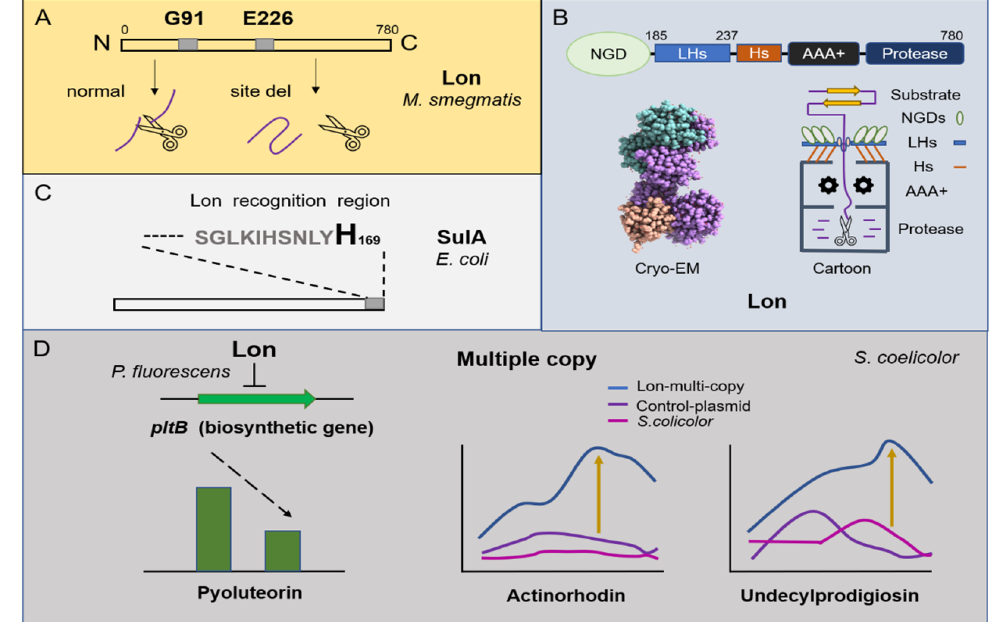
Figure 1. Overview of the degradation mechanism of Lon protease and its regulation on metabolism. ( A ) N-terminal amino acids G91 and E226 of Lon protease from Mycobacterium smegmatis are the most important active sites. ( B ) The cartoon structure of Lon protease and the Cryo–EM structure of the N-terminal domain of Lon E. coli (The Cryo–EM structure was downloaded from the PDB database). The whole length of Lon contains N-terminal globular domains (NGDs), three-helix bundles (3Hs), interlocked long helices (LHs), an AAA+ domain, and a protease chamber. ( C ) The degradation of SulA by Lon protease depends on its C-terminal histidine. ( D ) Lon protease negatively regulates the production of pyoluteorin in Pseudomonas fluorescens Pf-5. The multiple copies of the lon gene in S. coelicolor cause an increase in the yield of undecylprodigiosin and actinorhodin.